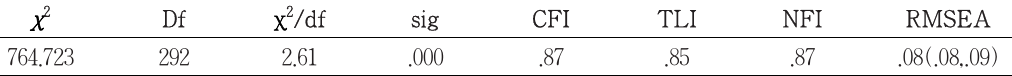
<Table 2> Fit indices for CFA of Research